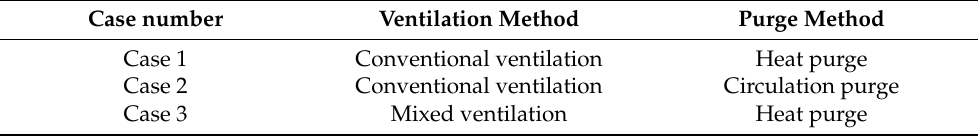
Table 4. Proposed cases for ventilation and purge